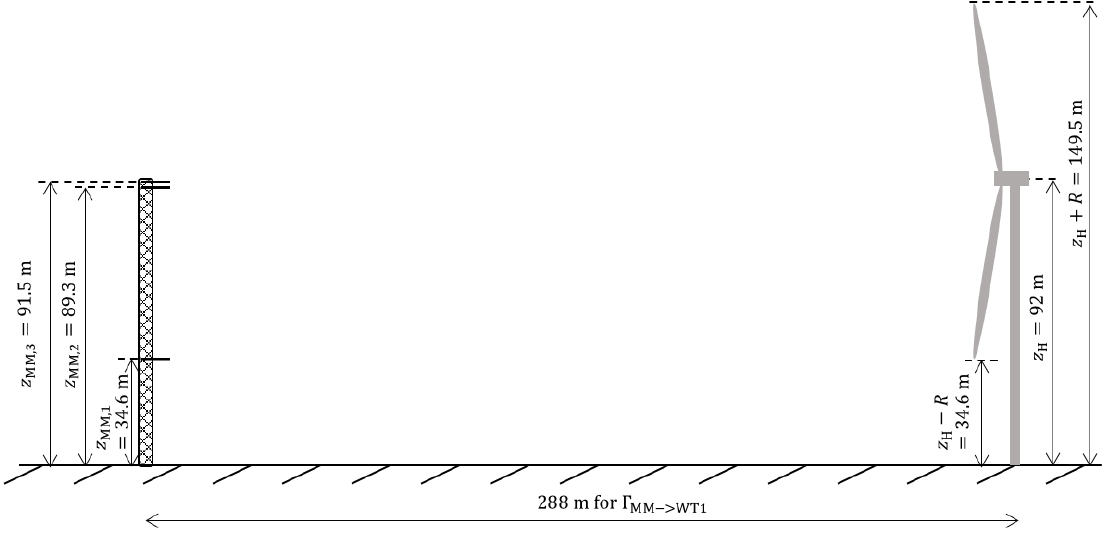
tion method was used here. The first 24 h of data were used to identify a scaling factor s = 0 . 0274 such that m 1 (1 + s ) = m 2 (1 − s ), where ( · ) indicates a mean value. This scaling fac- tor was then used to correct the sensor readings for the whole data set. For a long-term implementation, a similar correction could be applied periodically to compensate for time